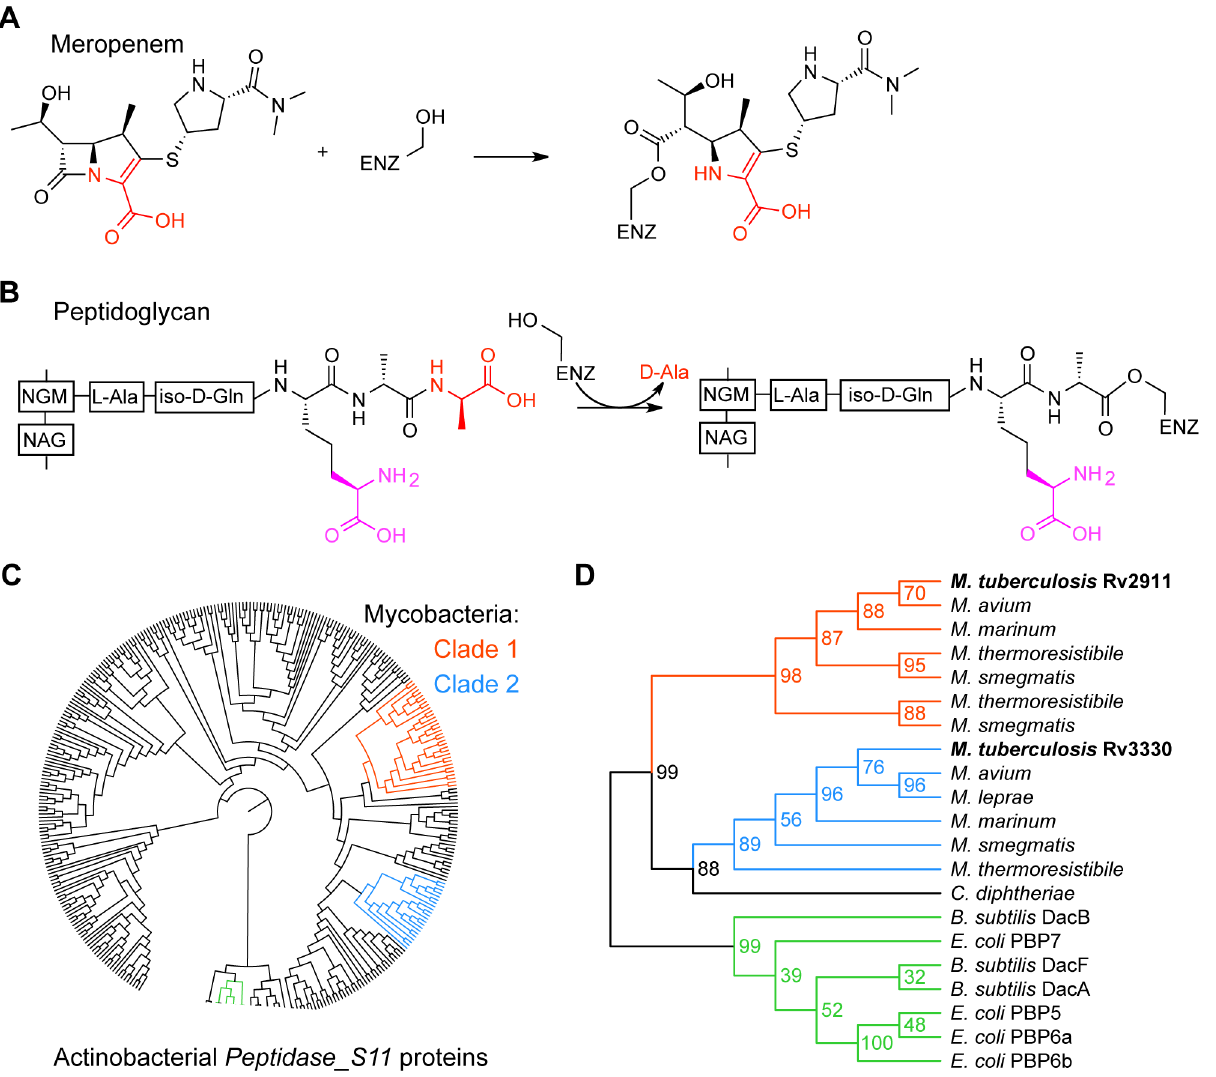
Fig. 1. Activity and phylogeny of Rv2911 and Rv3330. A. The beta-lactam, meropenem, contains a D-Ala-like group (red) and irreversibly acylates penicillin-binding proteins, including Rv2911 and Rv3330. B. Enzyme acylation by peptidoglycan stem peptide, the first step in peptidoglycan carboxy- and trans-peptidation, highlighting the similarity of the terminal D-Ala leaving group (red) and the D-Ala-like acceptor moiety of DAP (purple). C. Neighbor-joining tree of Peptidase_S11 family proteins of Actinobacteria fall into several clades. Of the two mycobacterial clades, Clade 1 (orange) contains Rv2911, and Clade 2 (blue) contains Rv3330. E. coli and B. subtilis Peptidase_S11 enzymes (green) form an out-group with several actinobacterial sequences. D. Maximum-likelihood tree of Peptidase_S11 proteins from select mycobacterial species, Corynebacterium diphtheriae , E. coli , and B. subtilis . High bootstrapping values confirm the separation of mycobacterial sequences into two distinct